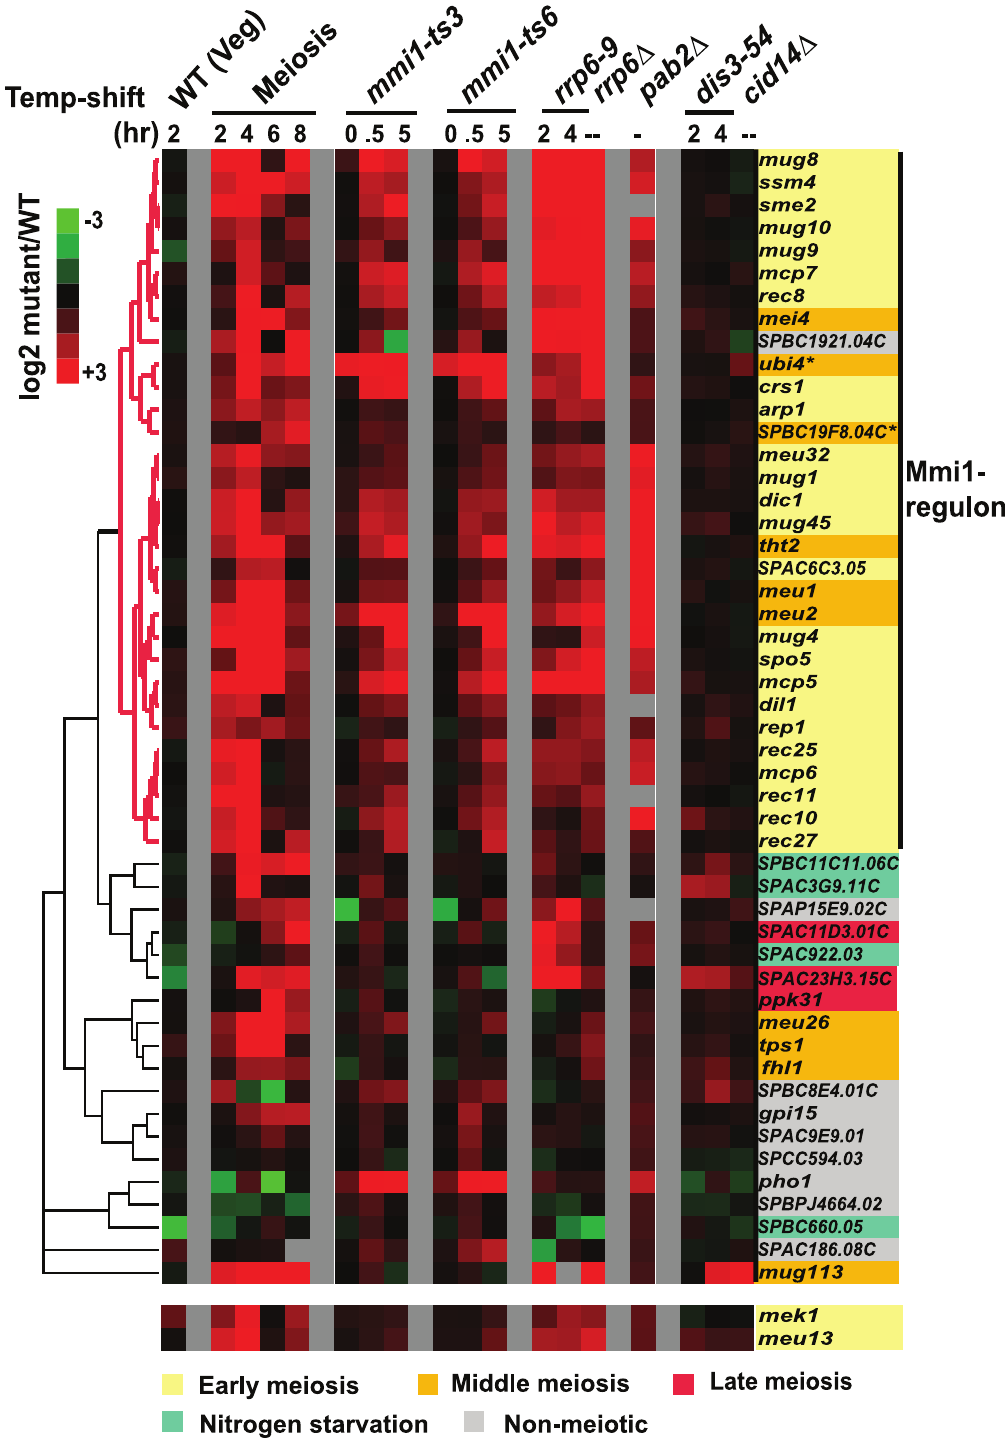
Figure 1. Effects of meiosis, mmi1 , and RNA processing mutants on transcripts. Hierarchical clustering of microarray data for 50 genes that accumulate most in mmi1-ts3 is shown for a meiotic time-course and various mutants. pab2 D data are from [8]. Other strains were grown vegetatively and conditional mutants were shifted to restrictive temperature. Colors represent the log 2 ratio of transcript levels in the mutant strain/wild-type control such that red means the transcript accumulates in the mutant. The 31-gene ‘‘Mmi1 regulon’’ is colored red in the dendogram. The independently-derived classification of genes with respect to meiotic timing is taken from [57]: yellow=early meiotic, orange=mid meiotic, red=late meiotic, green=nitrogen starvation and grey=non-meiotic. * Ubi4 and SPBC19F8.04c are probably not genuine Mmi1-targets (see text). Two genes, mek1 and meu13 , that may be real Mmi1-targets [3,8] but are not in our defined Mmi1-regulon are attached at the bottom of the cluster.